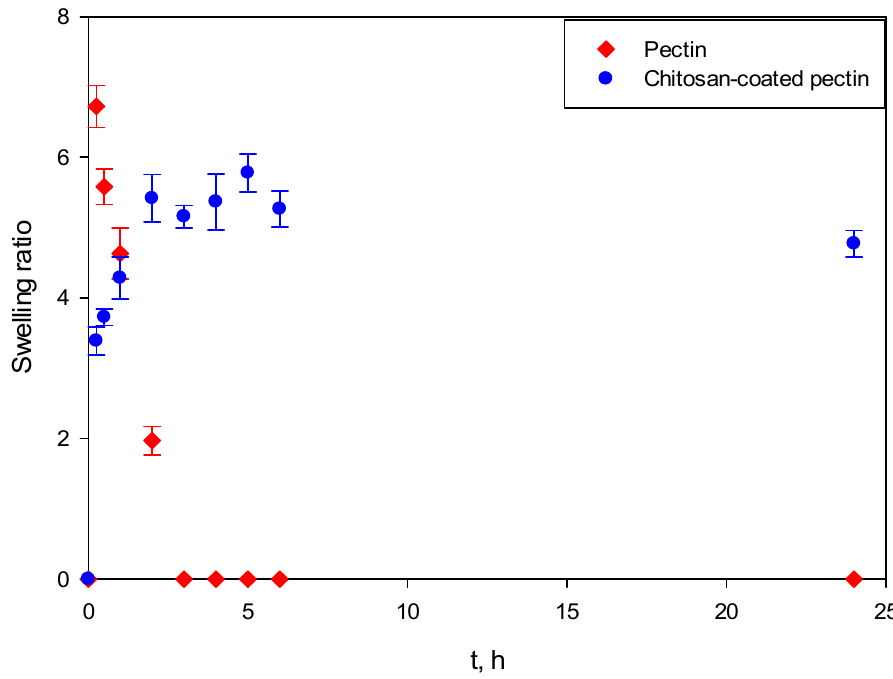
Figure 9. Swelling behavior of pectin aerogel and chitosan-coated pectin aerogels in SIF at pH = 6.8 for 24 h.